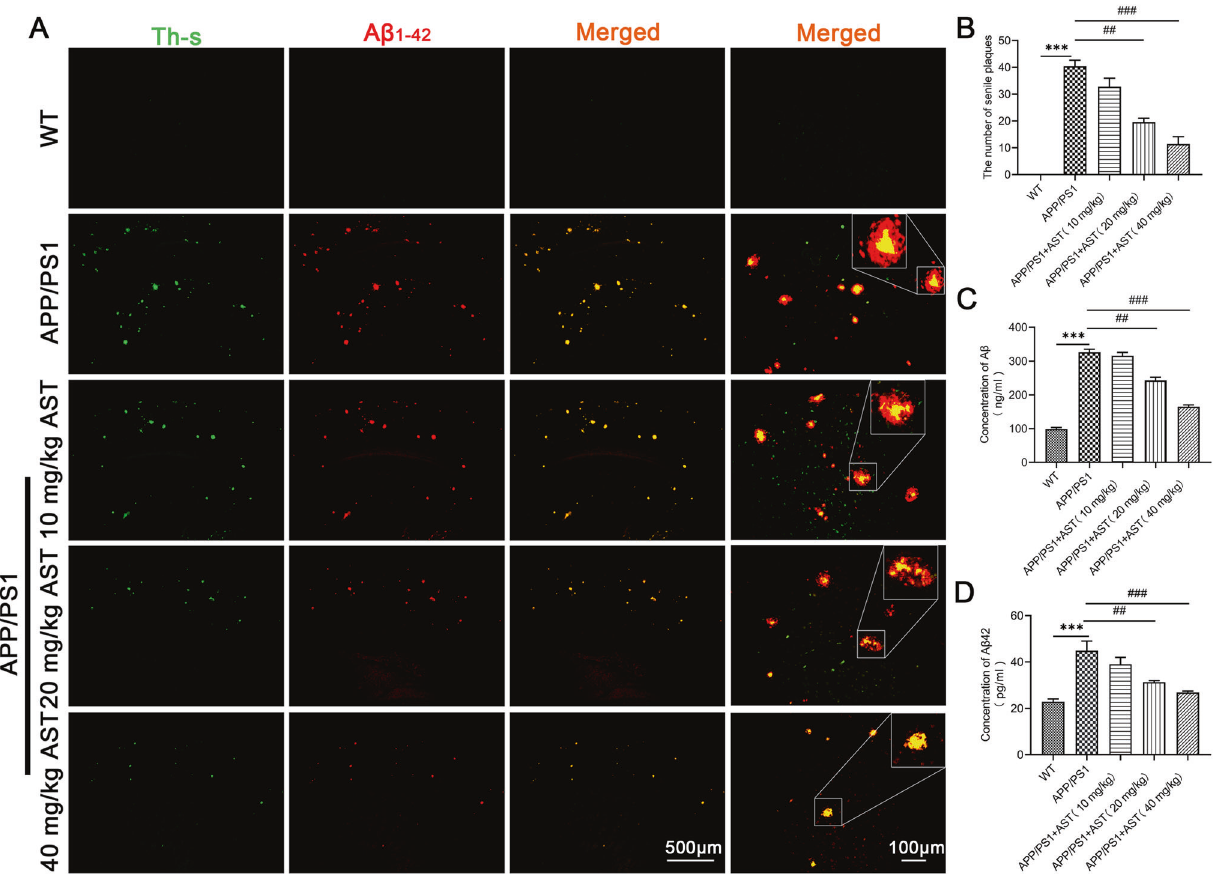
Fig. 3 AST reduced A β aggregation in the APP/PS1 mice. A Detection of SPs in the brain of mice by Th-S staining and immuno fl uorescent co-staining. Scale bar = 500 μ m in the three columns of images, and scale bar = 100 μ m in the last column of images. B Statistical analysis of the number of SPs in the brain of mice in the merged images at 5X magni fi cation (scale bar = 500 μ m) of A . C , D The A β and A β 42 levels in the serum of mice were detected by ELISA. Data were presented as mean ± SD, n = 3/group. *** p < 0.001 vs WT group, ## p < 0.01 and ### p < 0.001 vs APP/PS1